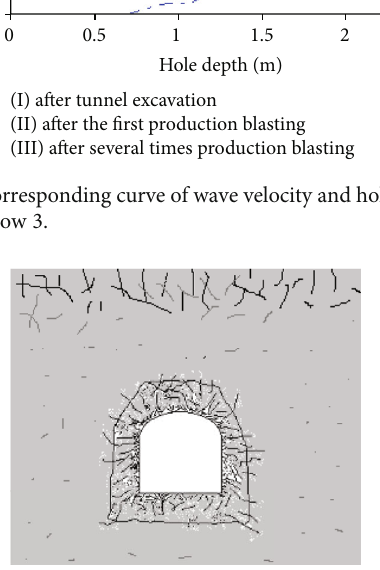
Figure 5: Crack distribution diagram of roadway surrounding rock.